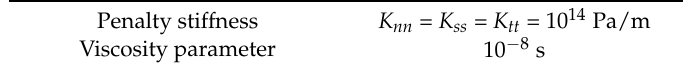
Table 3. Properties of the cohesive interface at which converged solution is